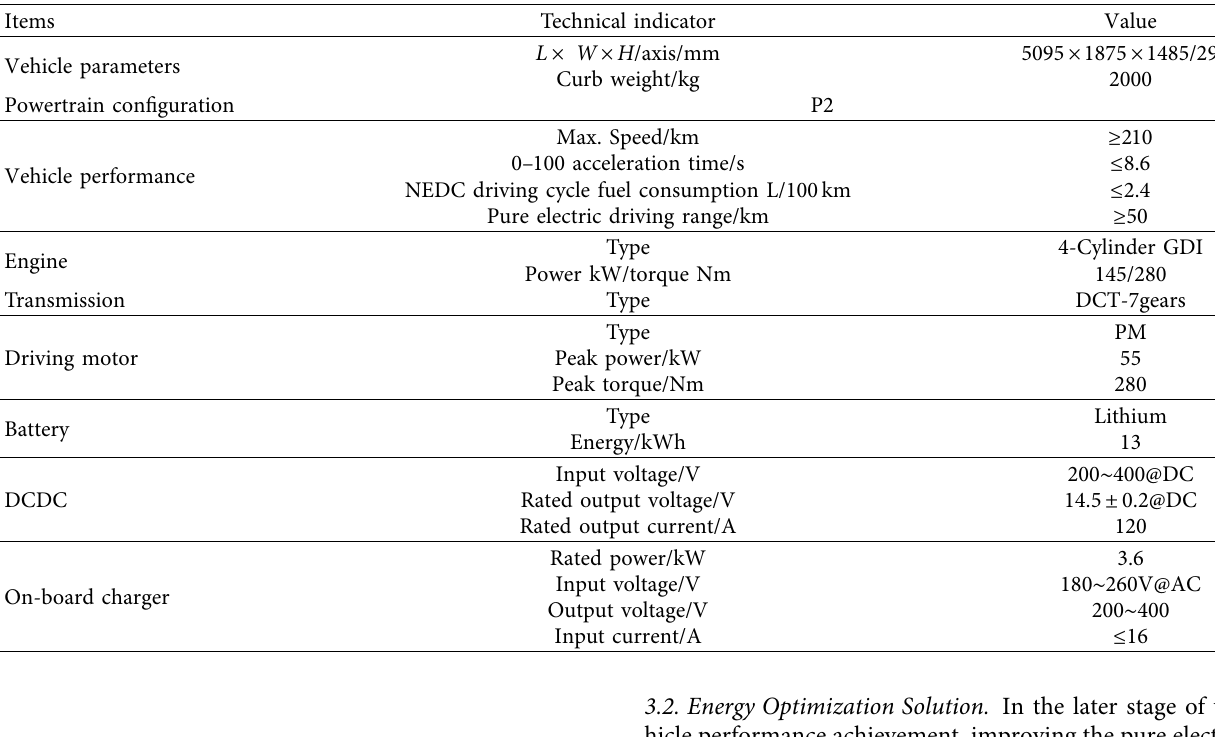
Table 1: Main technical parameters of the C-class vehicle and components.